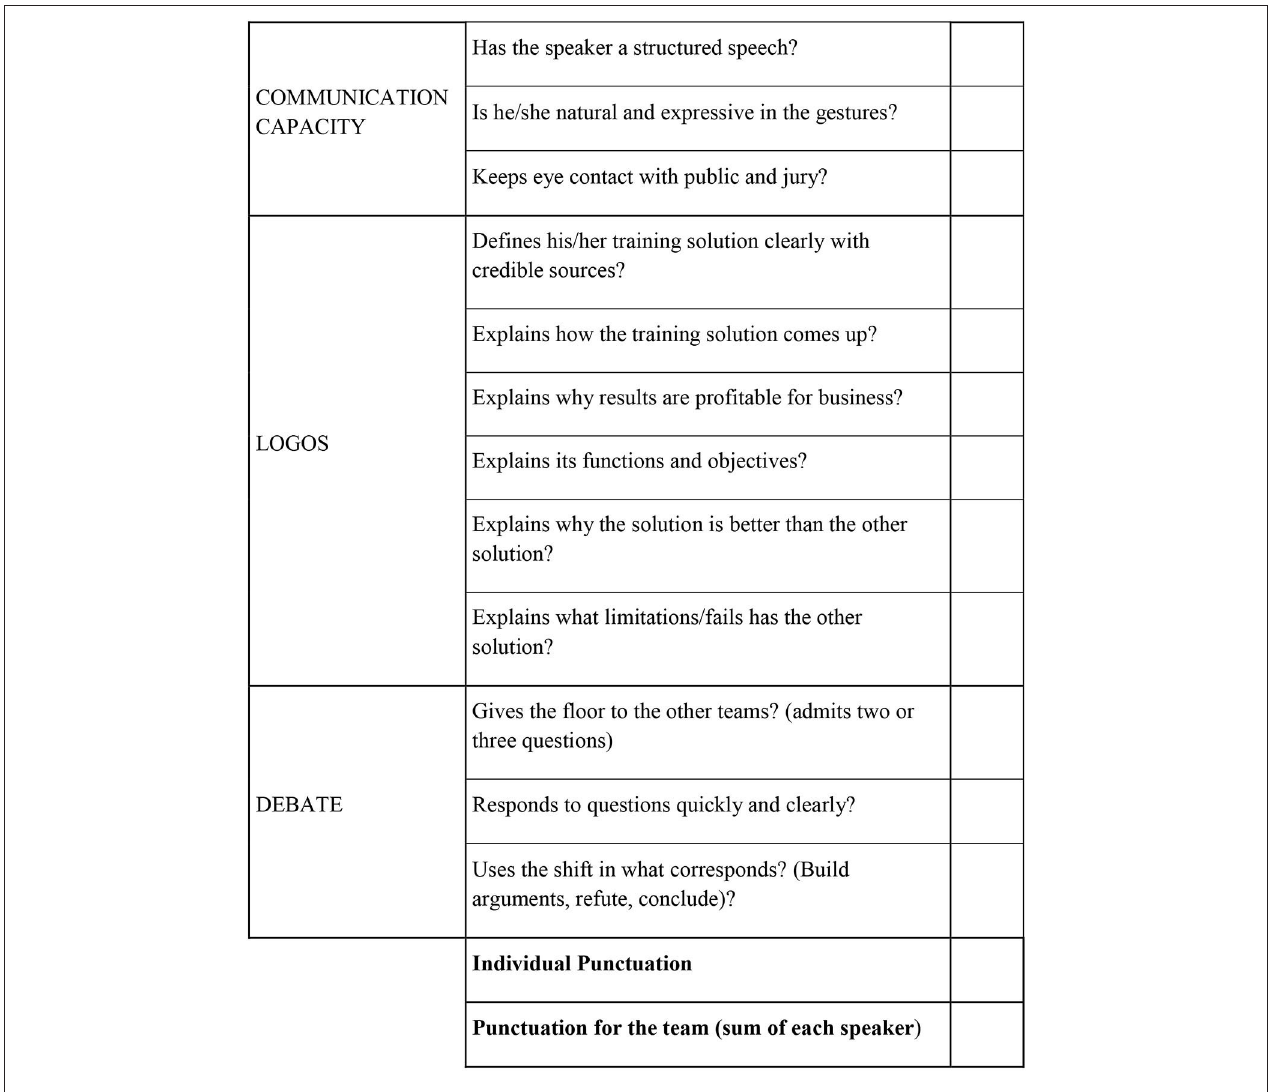
FIGURE 1 | Rubric of evaluation for debates. Source: Self